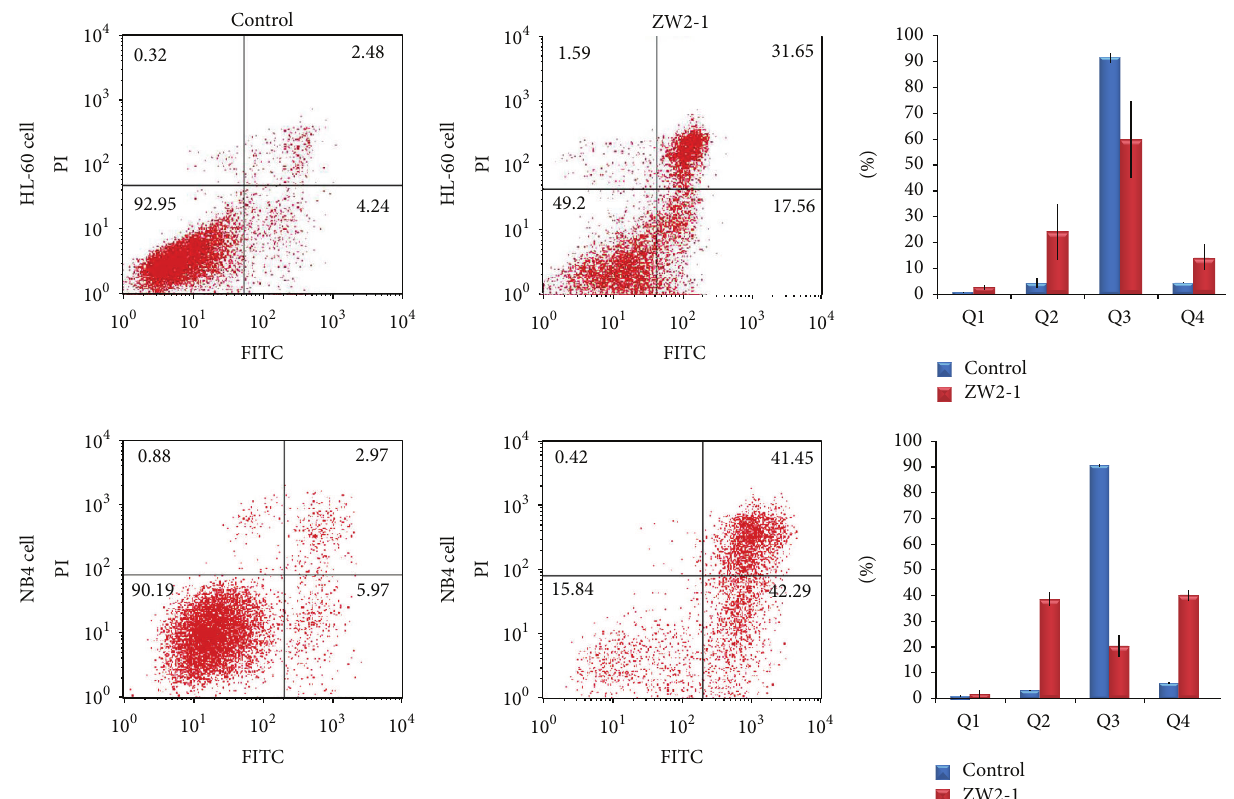
Figure 2: Effects of ZW2-1 on apoptosis of HL-60 and NB4 cells. Annexin V and PI double staining for apoptosis of cells 48 h after incubation withZW2-1incomparisontotheuntreatedcontrolcells.Allexperimentsarepresentedasmean ± SDofatleastthreeindependentexperiments performed in